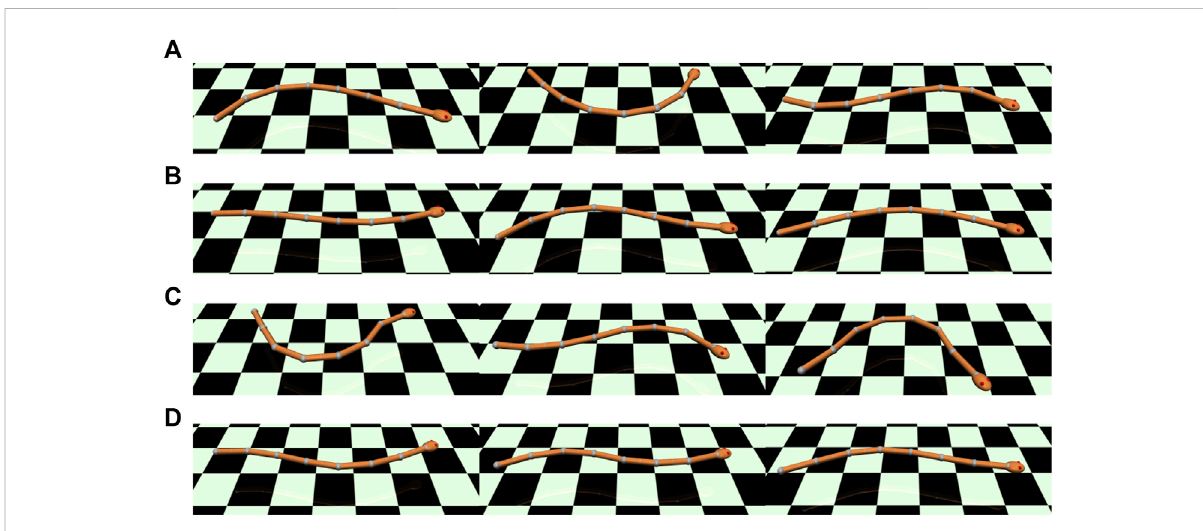
FIGURE 10 Montages show the swimming posture of the snake-like robot under different conditions. The frames are sorted in four columns from top to bottomandarerecorded atintervalsof0.4s.Pleaserefertothevideoassociatedwiththearticle. (A) GaitGE0:jointstiffness=0Nm/radwiththegait equation controller; velocity = 0.117 m/s; average power = 0.332 W. (B) Gait GE2: joint stiffness = 2 Nm/rad with the gait equation controller; velocity=0.201 m/s;averagepower=0.856 W. (C) GaitDRL0:jointstiffness=0Nm/radwiththeDRLcontroller;velocity=0.124 m/s;average